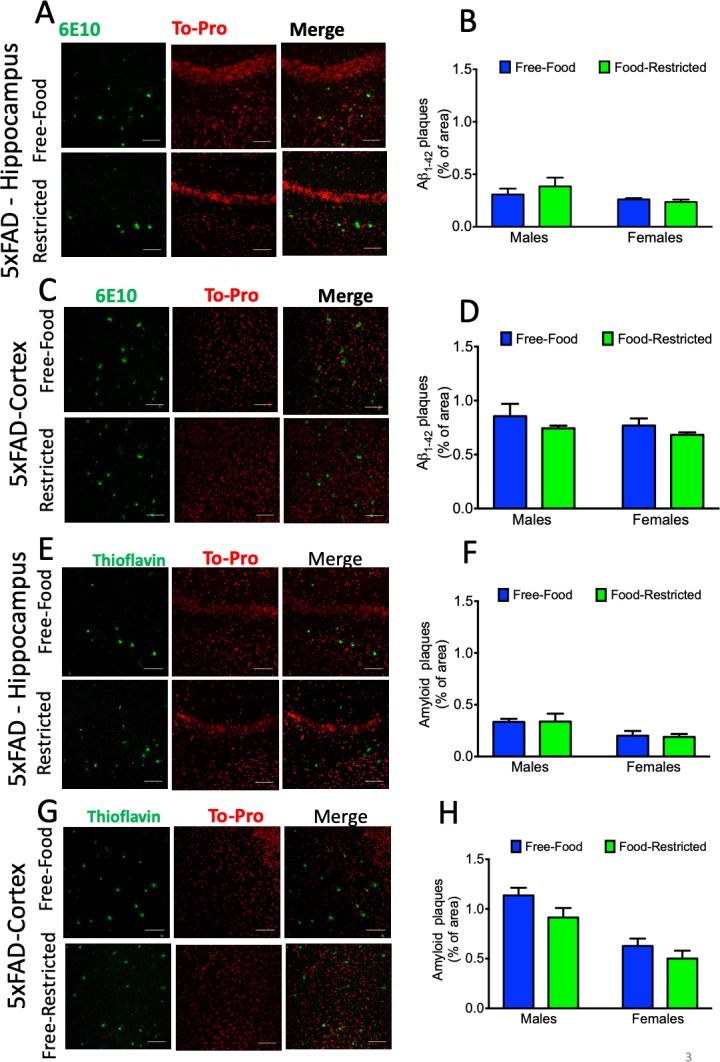
The effect of mild caloric restriction on amyloid pathology in male and female 5xFAD mice at 6 months of age.(A) Representative images of amyloid-beta 6E10 antibody and ToPro-3 (20x magnification; scale bar = 100 µm) and (B) quantification (mean ± SEM) of 6E10 immunoreactivity in the hippocampus (CA1) of mildly food-restricted and free food 5xFAD mice at 6 months of age (p=0.978 for males and >0.999 for females); (C) Representative images of amyloid-beta 6E10 antibody and ToPro-3 (20x magnification; scale bar = 100 µm) and (D) quantification (mean ± SEM) of 6E10 immunoreactivity in the cortices of mildly food-restricted and free food male 5xFAD mice at 6 months of age (p=0.931 for males and 0.976 for females); (E) Representative images of Thioflavin-S (Thio-S) and ToPro-3 (20x magnification; scale bar = 100 µm) and (F) quantification (mean ± SEM) of Thio-S in the hippocampus (CA1b) of mildly food-restricted and free food male 5xFAD mice at 6 months of age (p>0.999 for males and p>0.999 for females); (G) Representative images of Thioflavin-S and ToPro-3 and (H) quantification (mean ± SEM) of Thio-S in the cortices of mildly food-restricted and free food male 5xFAD mice at 6 months of age (p=0.076 for males and p=0.2993 for females). Data was compared by two-way ANOVA followed by Sidak’s multiple comparisons test. At least four samples obtained from each genotype/sex/brain region were analysed.